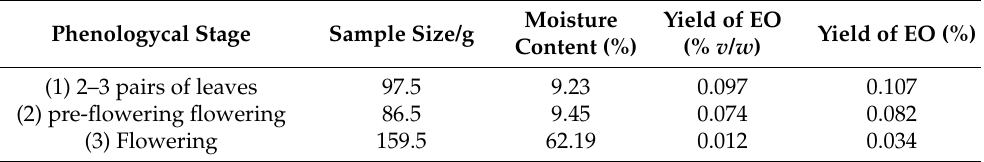
Phenological stage, samples size (g), moisture (%), and oil yield (%) of Marrubium friwaldskyanum in